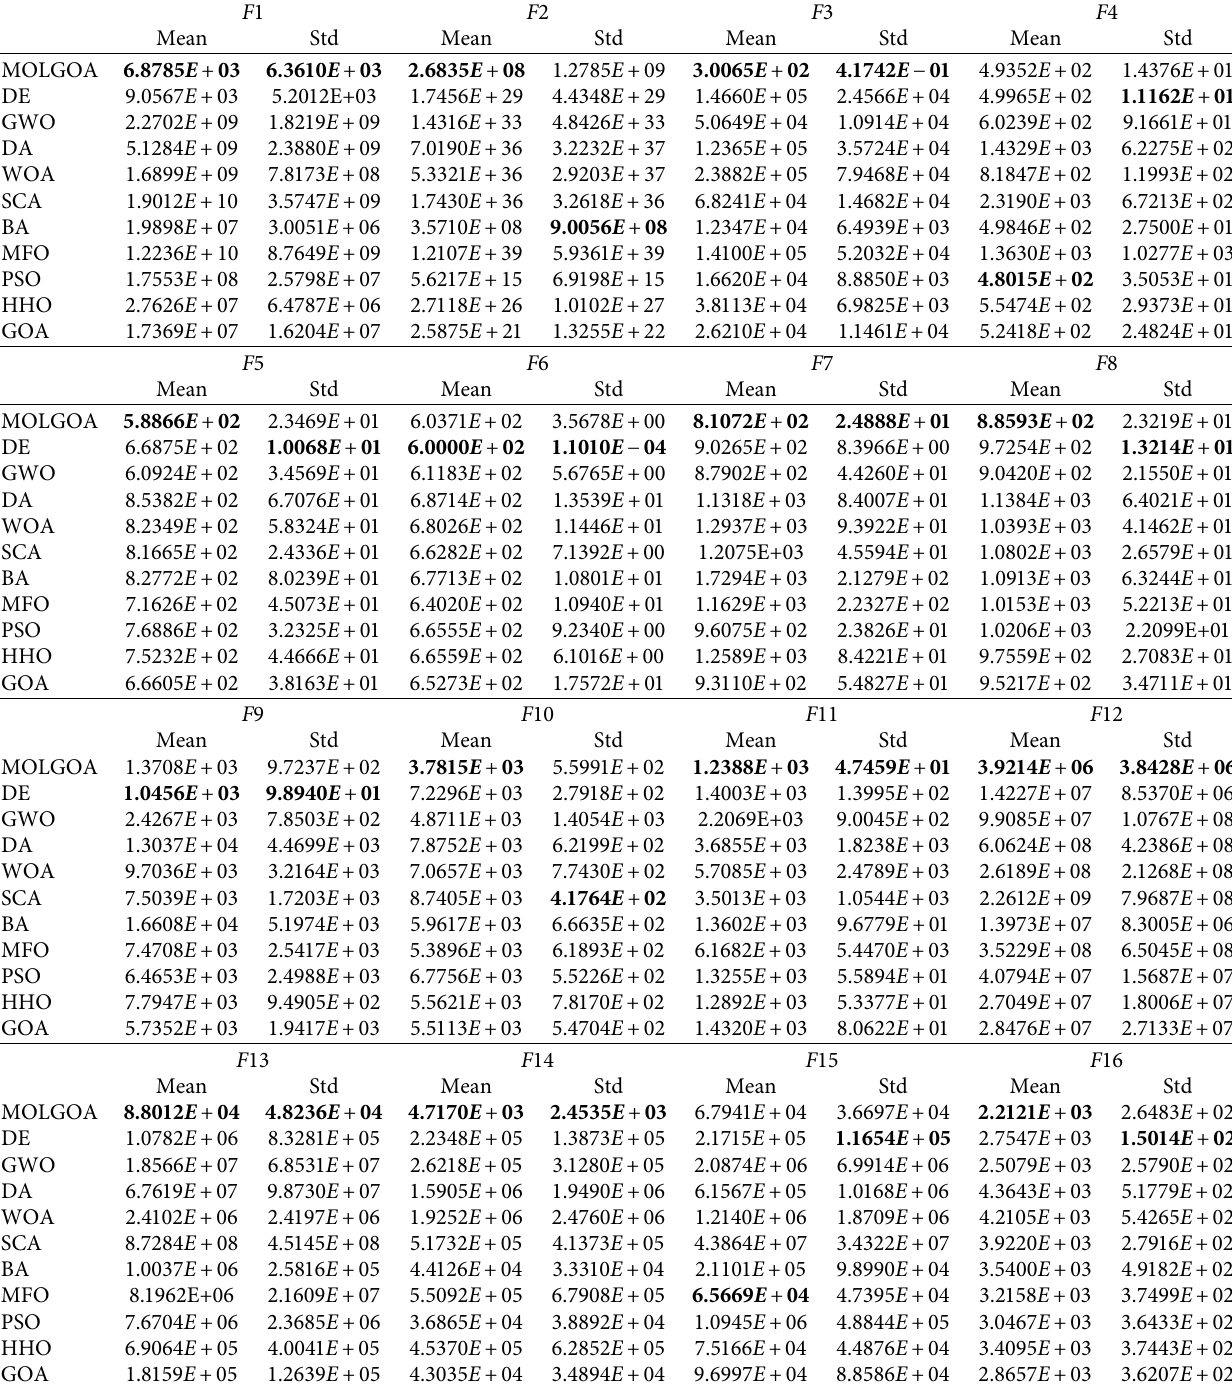
Table 6: Comparison results MOLGOA and other well-known